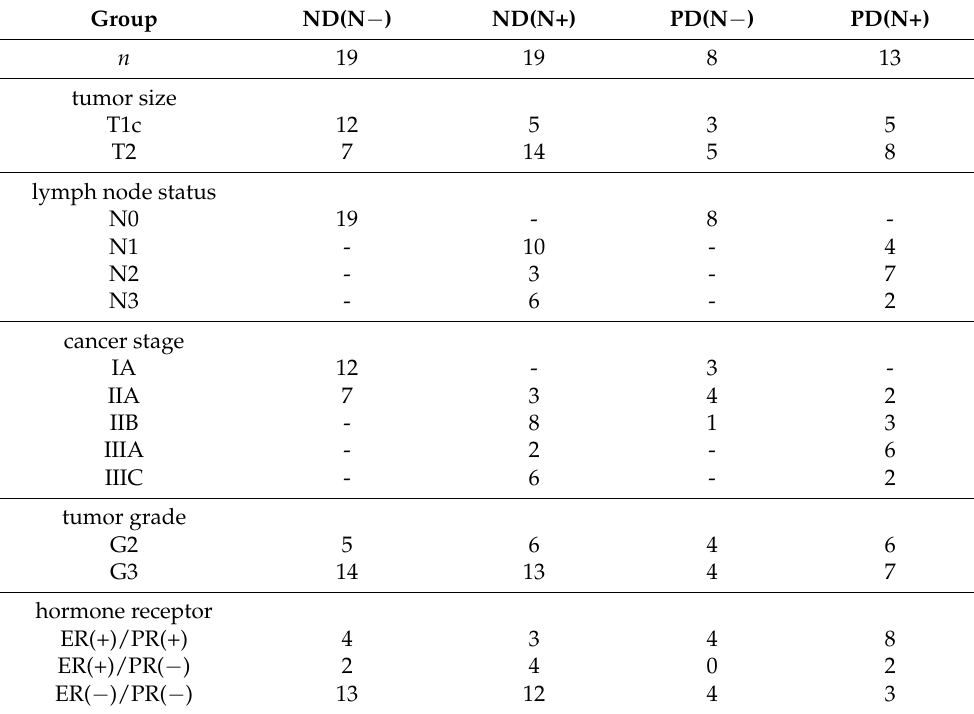
Table 1. Clinical characteristics of patients included in the